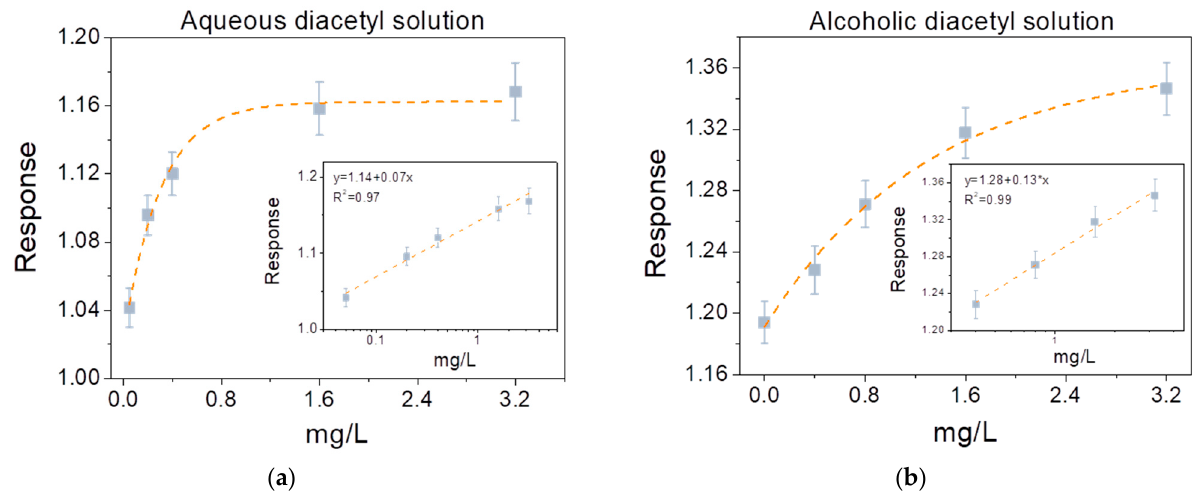
Figure 5. Sensor response in CO 2 atmospheres at different diacetyl concentrations in ( a ) aqueous solution and ( b ) alcoholic solution. Error bars are calculated on three runs.